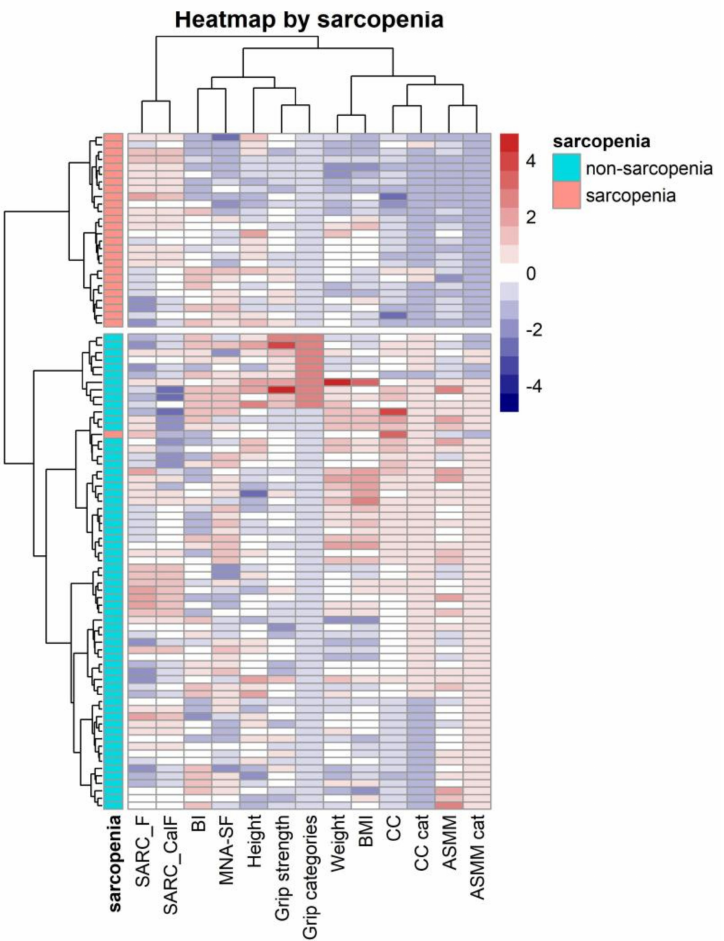
Figure 1. Clustering heatmap illustrating the potential clusters or subgroups of patients, using relevant variables of sarcopenia diagnosis and screening. ASMM (Appendicular Skeletal Muscle Mass); BI (Barthel Index); BMI (Body Mass Index); CC (Calf Circumference); CCI (Charlson Co- morbidity Index); MEDAS (Mediterranean Diet Adherence Screener); MNA-SF (Mini Nutritional Assessment-Short Form). All variables were scaled by their means. Clustering was performed by rows, i.e., patients, using Euclidean distances and Ward’s clustering method. Color patterns followed the intensity of this relationship. The redder reflects that this pattern is above average and the bluer means the